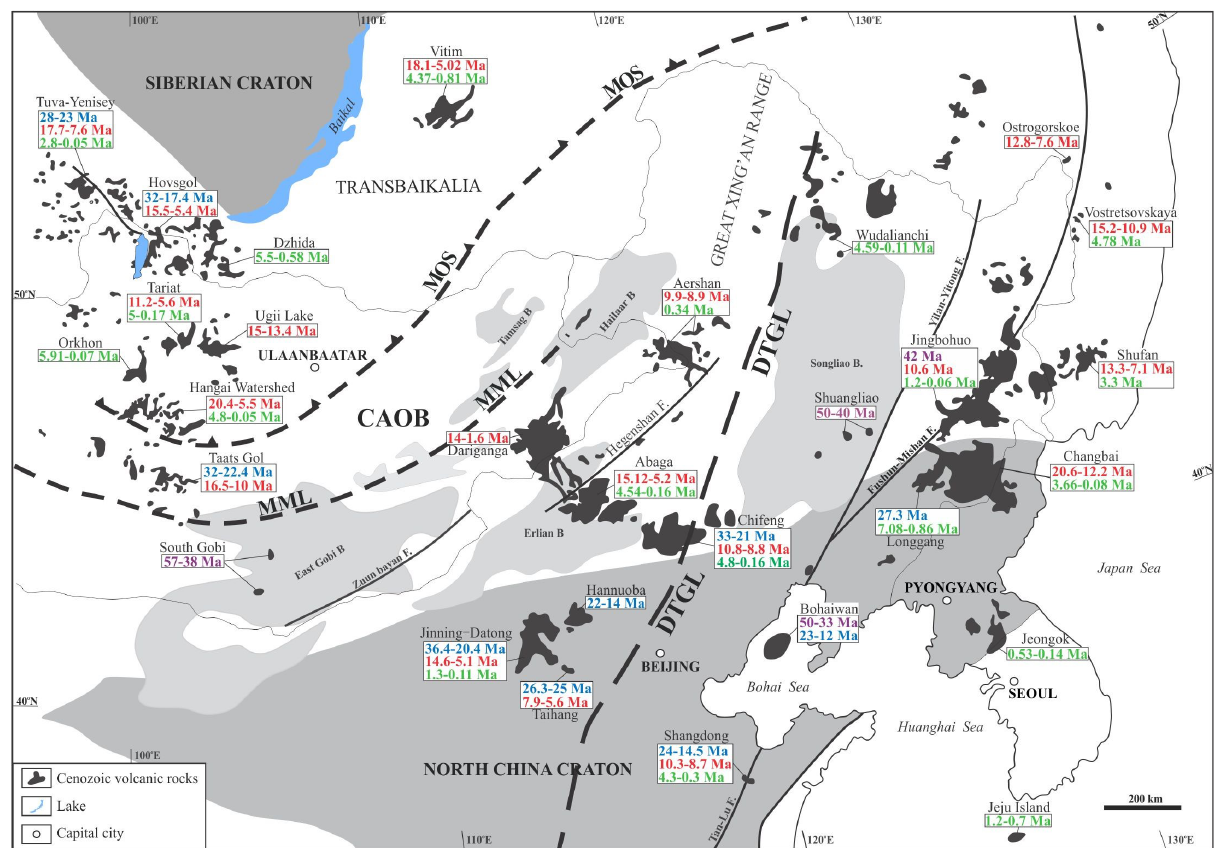
Fig. 10. Simplified map showing the temporal-spatial distribution of the Cenozoic OIB-like volcanic rocks in NE Asia. The numbers in brown, blue, red, and green colors in rectangles denote available K-Ar or Ar-Ar ages of the volcanic rocks that are approximately between 60-40, 35-20, 15-5, and <5 Ma, respectively. MOS: Mongol- Okhotsk suture; MML: Main Mongolian Lineation; DTGL: Daxing’anling-Taihangshang gravity lineation; CAOB: central Asian orogenic belt. Data sources are from Höck et al. (1997), Liu et al. (2001), Devyatkin (2002), Tang et al. (2006), Chashchin et al. (2007), Ryu et al. (2011), Xu et al. (2012), Ivanov et al. (2015), and Yarmolyuk et al.